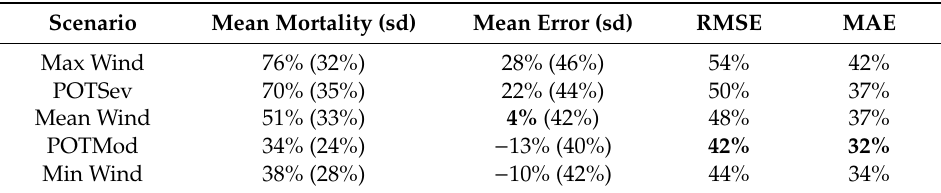
Table 5. Mean fire-induced mortality as a percent of pre-fire, live tree basal area; mean mortality prediction error; root mean square error (RMSE), and mean absolute error (MAE) by weather scenario ( n = 342), with errors closest to zero per error metric in bold.